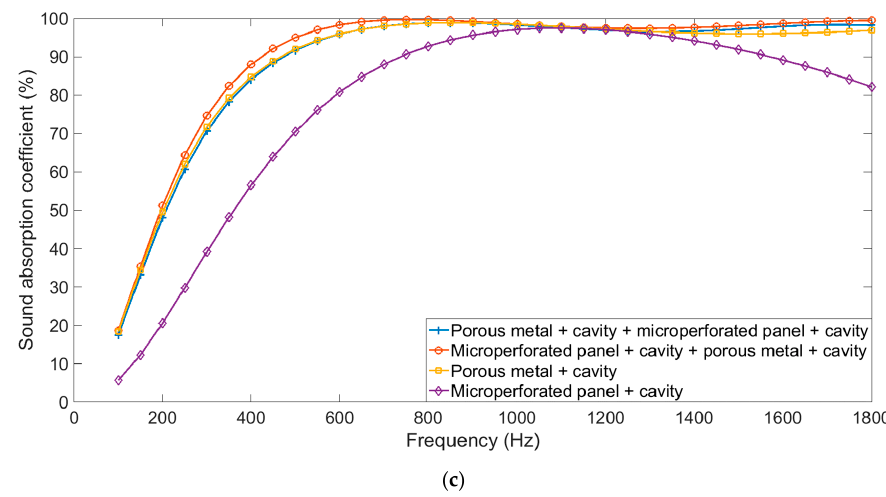
Figure 2. Distributions of sound absorption coefficients for the theoretical optimal sound absorbers in the frequency range of 100–1800 Hz with different limited total thicknesses. ( a ) 30 mm; ( b ) 50 mm; ( c ) 100 mm.